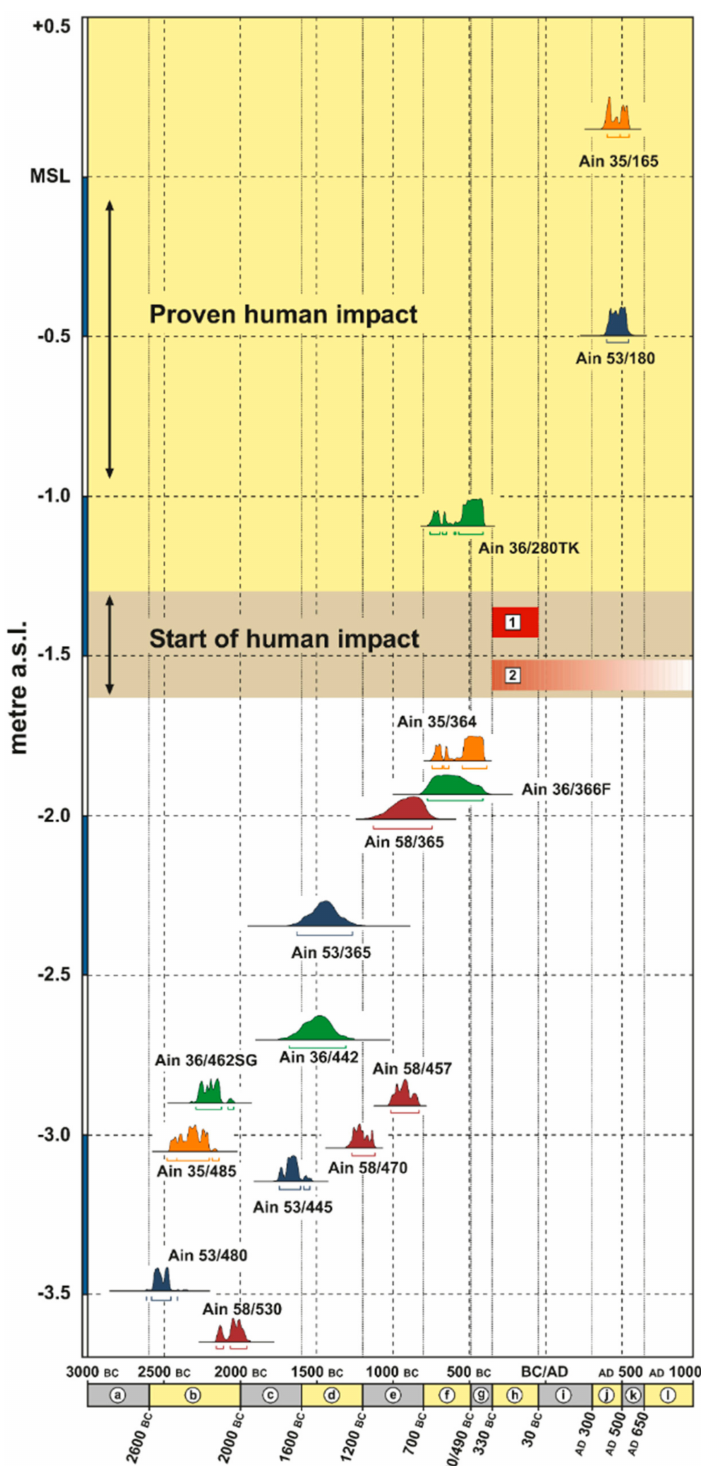
Figure 7. Synopsis of radiocarbon ages of corings Ain 35, 36, 53, and 58 (Table 1). Additionally, the zone of the cores where the human impact is about to start and where it is proven are marked. Historic periods: ( a ) Neolithic; ( b ) Early Minoan; ( c ) Middle Minoan; ( d ) Late Minoan; ( e ) Dark Ages; ( f ) Archaic; ( g ) Classical; ( h ) Hellenistic; ( i ) Roman Imperial; ( j ) Late Antiquity; ( k ) Early Byzantine; ( l ) Middle Byzantine. Human Impact: (1) Construction style of the wall dates it to Hellenistic times; (2) No traces of human impact of Classical age or older have been found in the